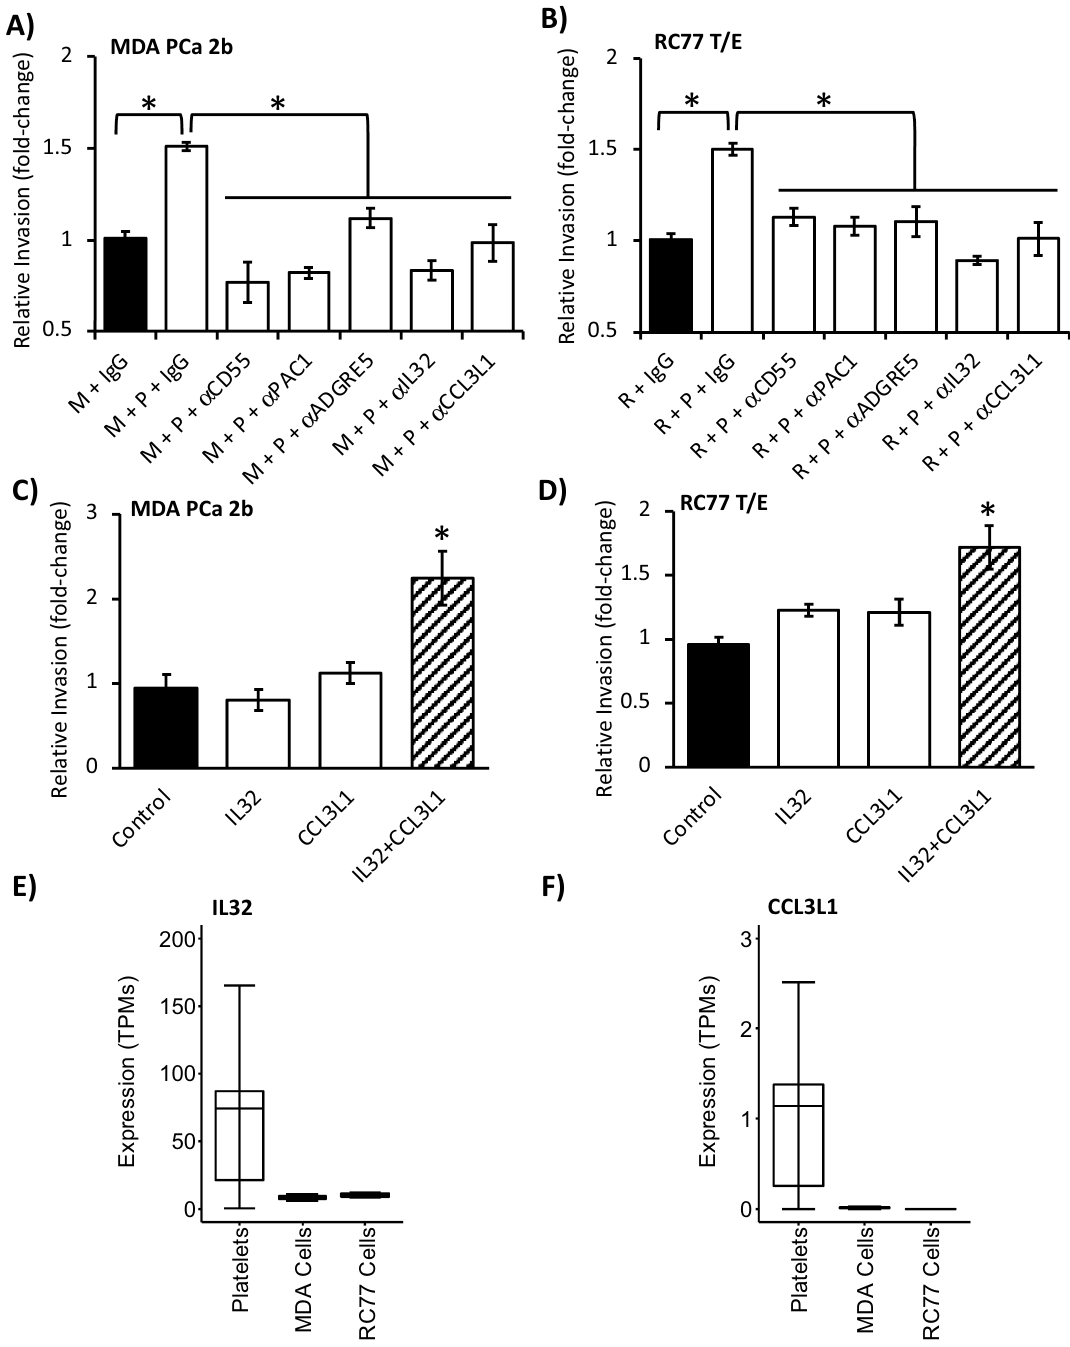
Figure 6. CD55/α IIb β 3 -ADRE5, CCL3L1-CCR and IL32 signaling axes participate in PLT-stimulated PCa cell invasion. ( A , B ) Platelet (P)-stimulated MDA PCa 2b (M) and RC77 T/E (R) invasion was examined in the presence of IgG isotype control (5 µg/ml) or the indicated blocking antibody (α; 5 µg/ml). Cell:platelet ratio was 1:1000. Data presented as the mean ± SEM of n = 8–10 independent determinations and analyzed by ANOVA and Tukey post-hoc test, * P < 0.05. ( C , D ) PCa cell invasion was measured following exogenous administration of 50 nM IL32 alone, 10 nM CCL3L1 alone or the combination of IL32 and CCL3L1. Data presented as the mean ± SEM of n = 3 independent determinations and analyzed by ANOVA and Dunnett’s post-hoc test, *, P < 0.05; significantly different from control. ( E , F ) IL32 and CCL3L1 are expressed in platelets, but absent or nearly absent in MDA PCa 2b and RC77 T/E PCa cell lines based on RNA-Seq analysis. The expression levels are given as transcripts per million (TPM) and presented as Box-and-Whiskers plots. Box: top quantile, mean and bottom quantile. Whiskers: top extreme (90 percentile of the dataset) and bottom extreme (10 percentile of the dataset). Platelet values derived from RNA-Seq of n = 44 healthy volunteers 24 . PCa cell line values derived from RNA-Seq (GEO accessions GSE213223 (current study) and